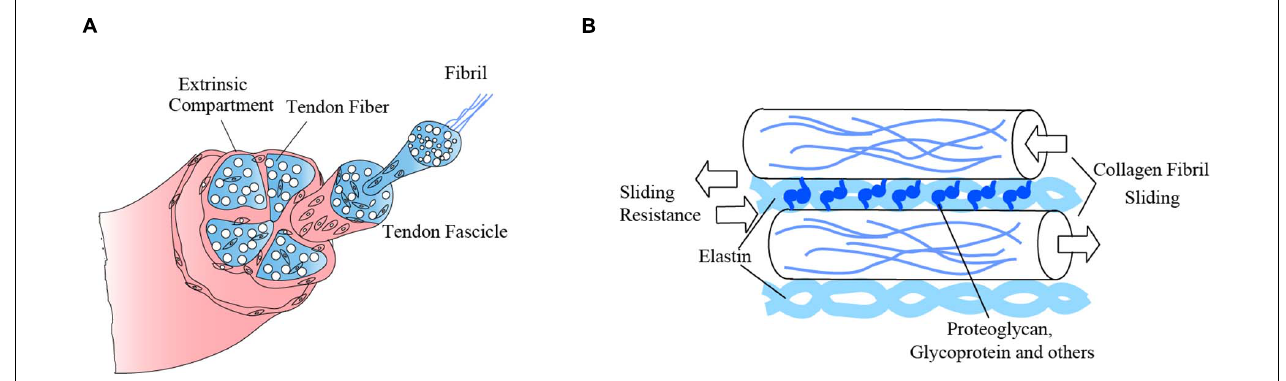
FIGURE 1 | The biomechanics of different components of tendon matrix ensure tensile strength of the whole tendon. (A) The main component of tendon is collagen. The base of tendon tissue is collagen fibers, which consist of collagen fibrils. (B) The tendon matrix components, collagen fibrils, elastin fibrils, proteoglycan, glycoprotein, and other macromolecules, combine with each other to provide micromechanics. These micromechanics interact and give rise to the macro-mechanics of tendon, which enable its biomechanical